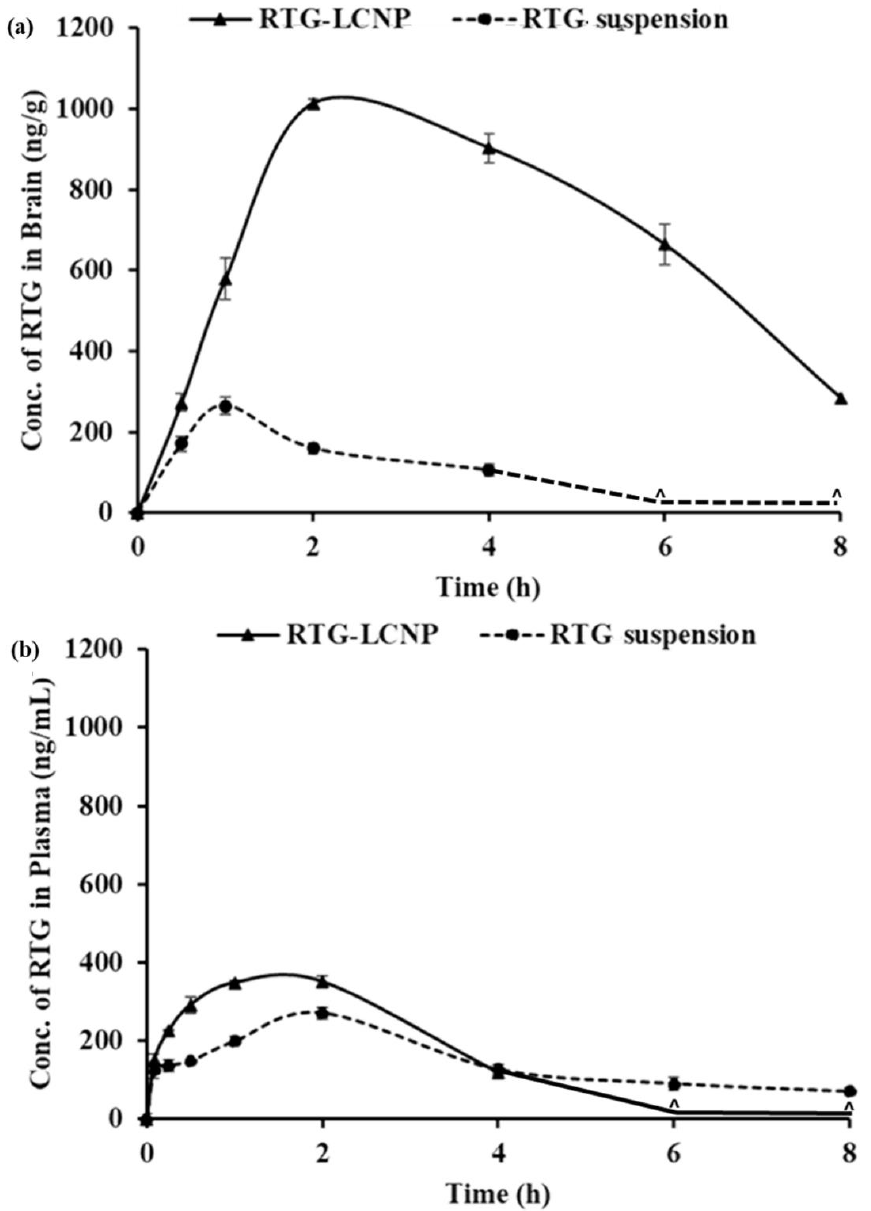
Figure 8. PK profiles of RTG attained after i.n. administration of RTG-LCNP (LCNP 15) and RTG suspension in ( a ): Brain and ( b ) : Plasma. ‘^’ in both the profiles denote that the concentration of RTG was not detected at those time points in brain matrices and plasma.